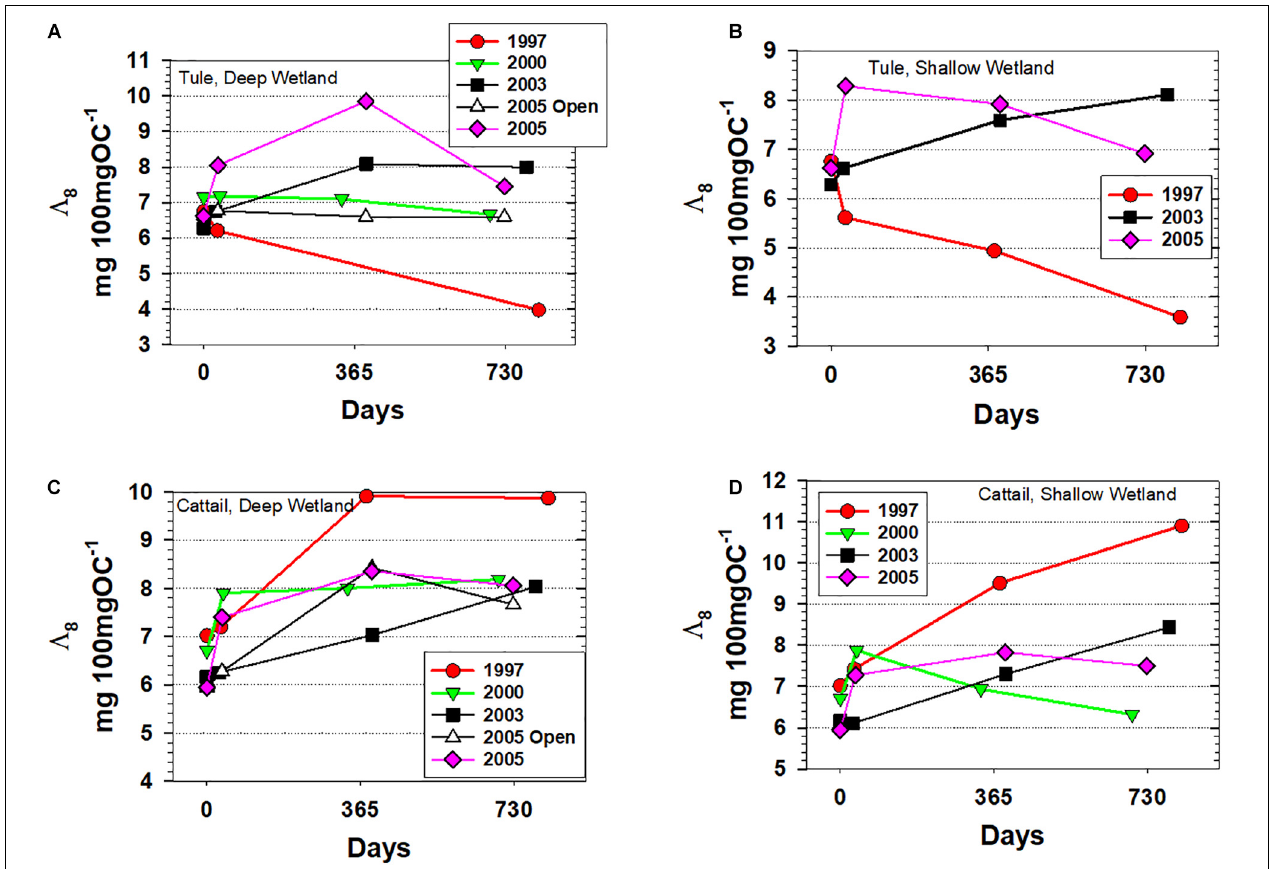
FIGURE 3 | Carbon-normalized lignin yields for all experiments plotted versus days. (A) Tule litterbags from the Deep wetland, (B) Tule litterbags from the Shallow wetland, (C) Cattail litterbags from the Deep wetland, and (D) Cattail litterbags from the Shallow wetland.